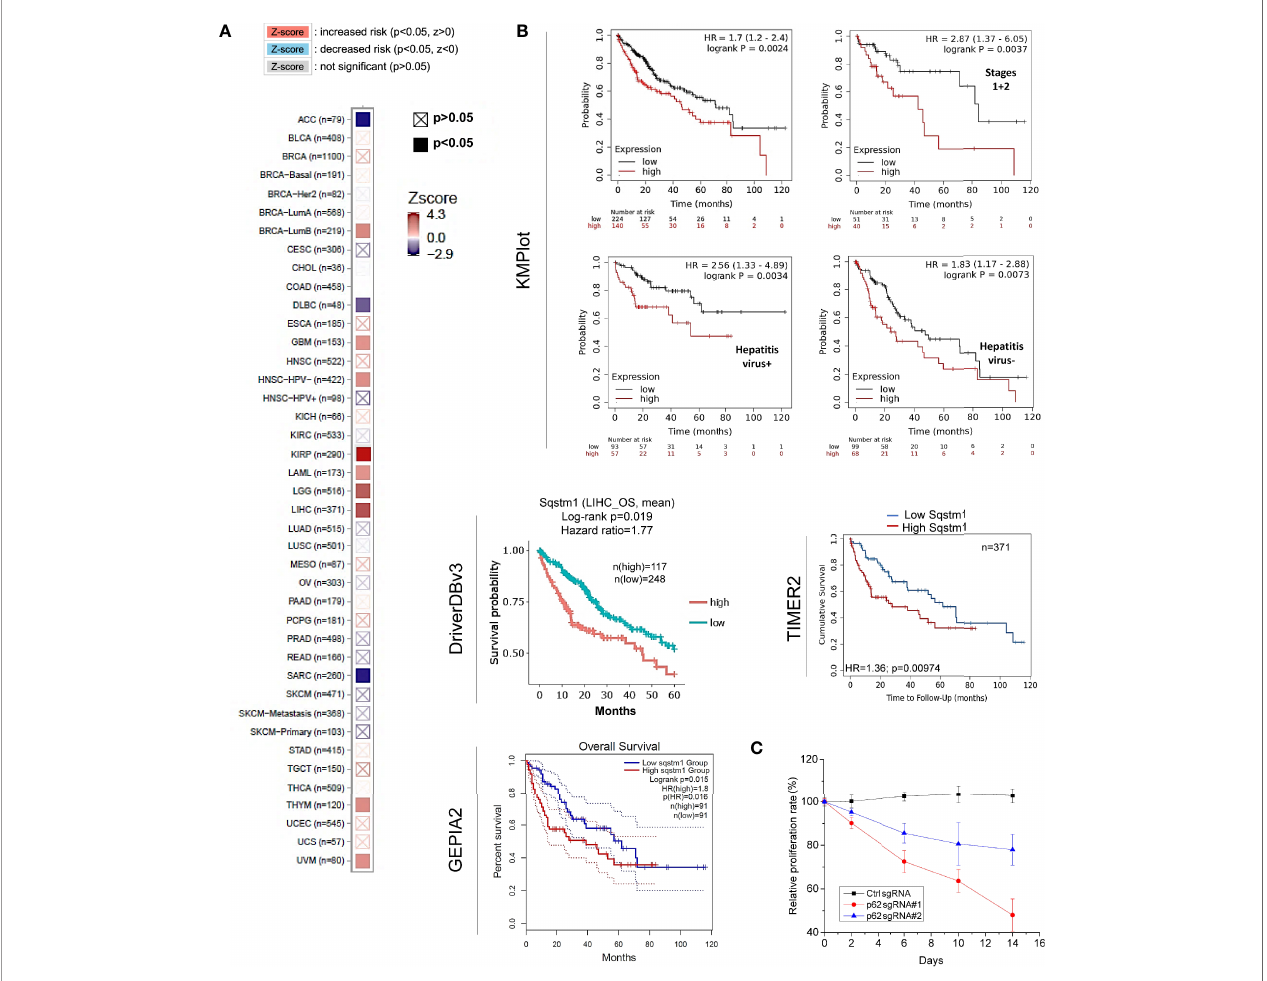
FIGURE 8 | Sqstm1 expression is associated with the overall survival of certain cancers. (A) Sqstm1 expression level is associated with the overall survival (OS) of certain cancer patients. (B) Sqstm1 expression level reversely correlates with the OS of LIHC patients. (A) is results from TIMER2, and (B) from different portals showing the consistency. For KMPlot, the settings were: JetSet best probe set, excluding outlier arrays, and univariate. (C) p62/Sqstm1 depletion reduces the proliferation of the liver cancer cell line Huh7D12. The proliferation rate of the cells with control sgRNA at each time point was set to